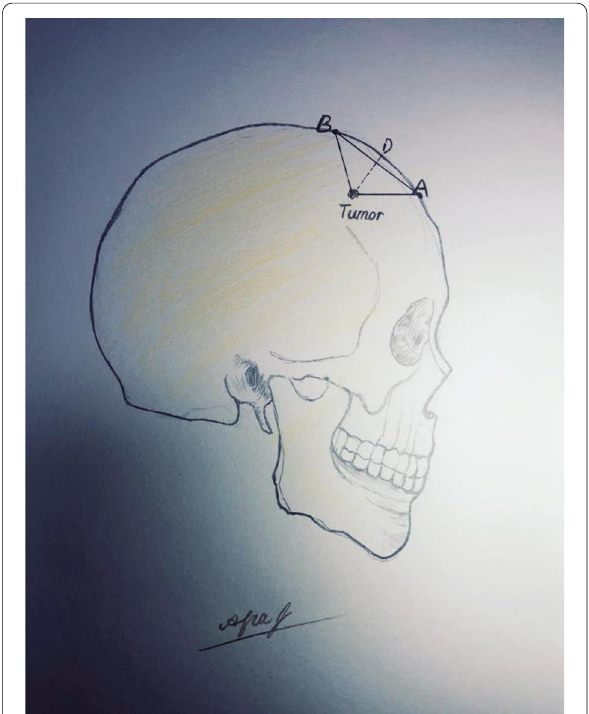
Fig. 4 According to the measurement results and the triangle Pythagorean Theorem, the projection point D of the tumor on the scalp can be calculated. And the arc AB is approximately equal to the line segment AB